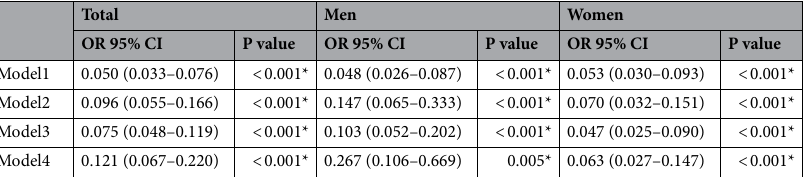
Table 2. Correlation between serum APOB and AF. Model 1: crude, no adjustment. Model 2: adjusting for CHD, hypertension, diabetes, β-blockers, CCBs, ACEI/ARB, and statins. Model 3: adjusting for AST, SCr, SUA, ALB, APOA1, and PAB. Model 4: adjusting for all these factors. Abbreviations as in Table 1. *Statistically significant value (P < 0.05).